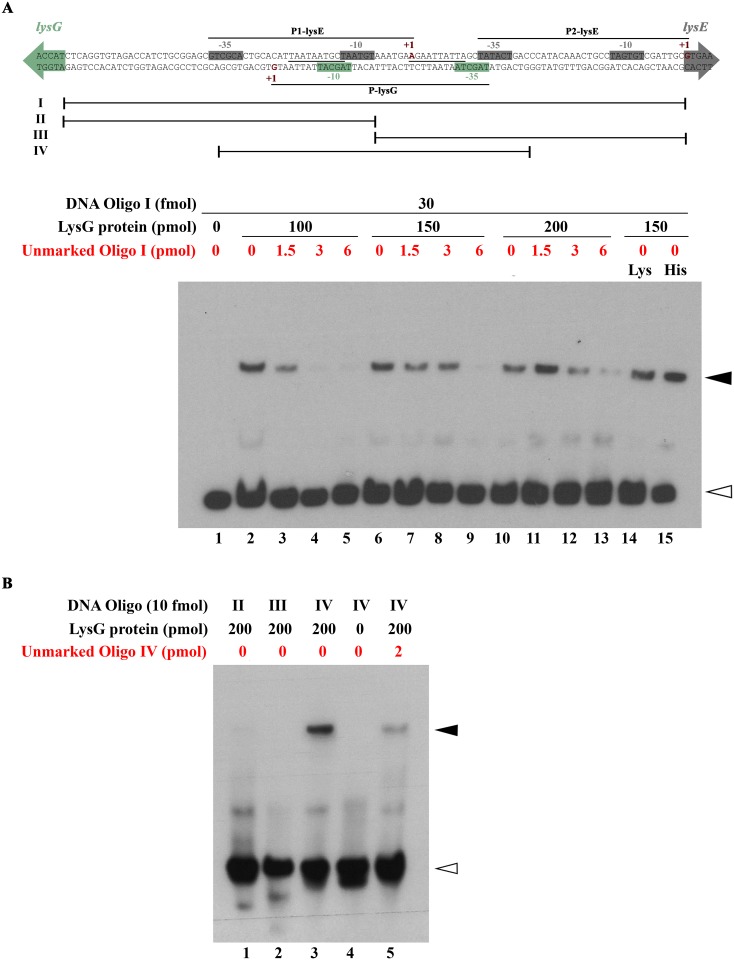
LysG(Mt) binds to the upstream region of lysE(Mt).(A) Intergenic region between lysG(Mt) and lysE(Mt). The lysG(Mt) and lysE(Mt) transcriptional start sites are indicated with +1 (in red and bold type). The promoter binding motifs (-10 and -35 motifs) are marked as boxes. The coloured arrows denote the beginning of the open reading frames. The location of the inverted repeat within the intergenic region is marked (underlined). The position of the labeled oligonucleotides used for the electrophoretic mobility shift assay is shown (I to IV). 30 fmole of labeled oligonucleotide I was incubated with increasing concentrations of LysG(Mt), indicated for each lane. As control no protein (lane 1) and 50, 100 or 200-fold molar excess of unlabeled target DNA (oligonucleotide I) were added, marked in red. 5 mM of the co-effector lysine (lane 14) and 3.34 mM of histidine were added (lane 15). Bands corresponding to free DNA are marked by open arrowheads, whereas bands with DNA in complex with LysG(Mt) are marked by filled arrowheads. Results are representative of two independent experiments. (B) Electrophoretic mobility shift assay with 200 pmole of LysG(Mt) was done in combination with 10 fmole of the three subfragments (oligonucleotides II to IV). As control no protein (lane 4) and 200-fold molar excess of unlabeled target DNA (lane 5) were added.